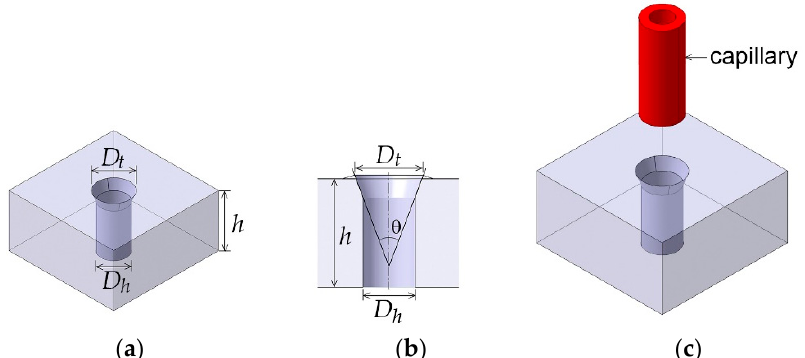
Figure 3. ( a ) Drilled microhole, ( b ) countersink microhole, and ( c ) inserting capillary into the countersink microhole. Here, D t is diameter of tapered top and D h is diameter of microhole. θ is the tapering angle. h is the thickness of the substrate.